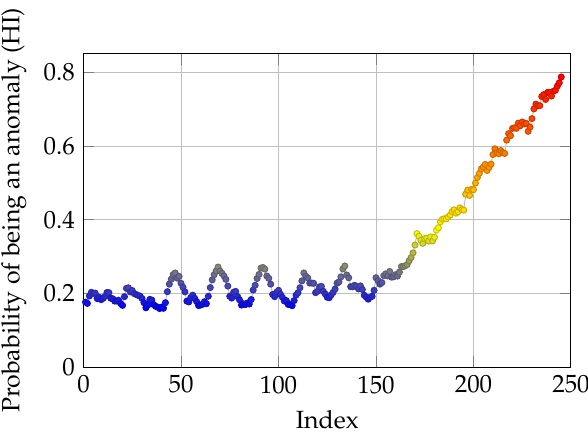
Figure 10. Results of simulation from incremental disturbance. HI values tend to oscillate, due to the partly non-representative training